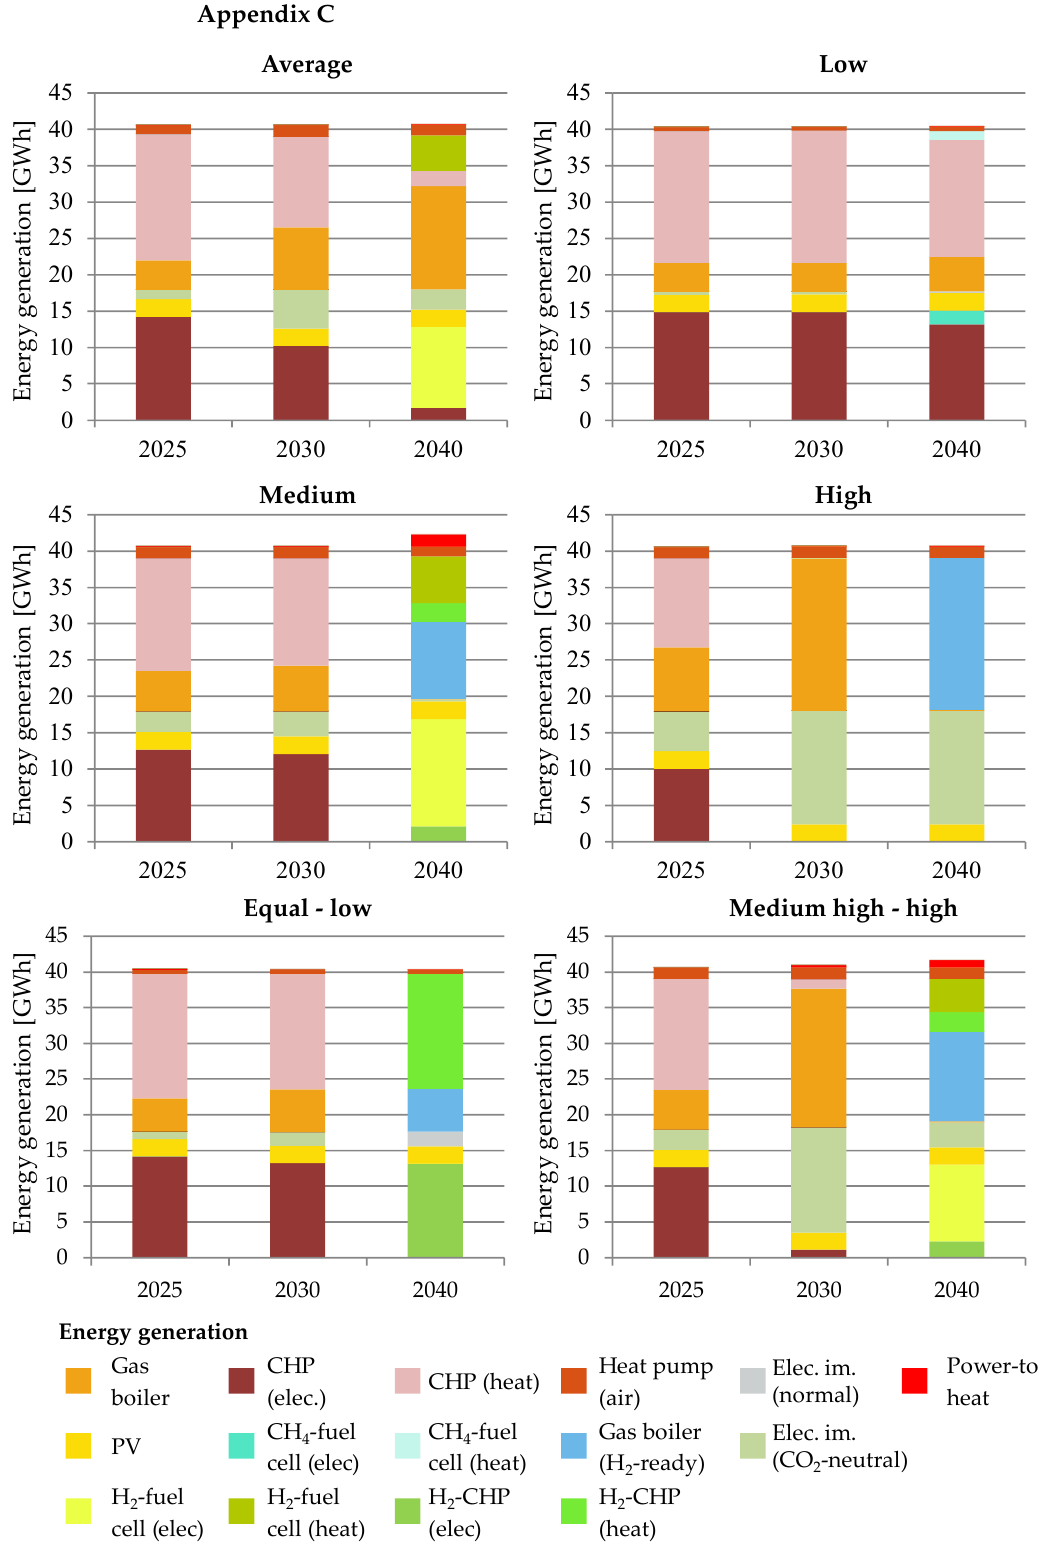
Figure A3. Energy generation for different scenarios with uncertain CO 2 prices and energy carrier costs (myopic, with CCS).